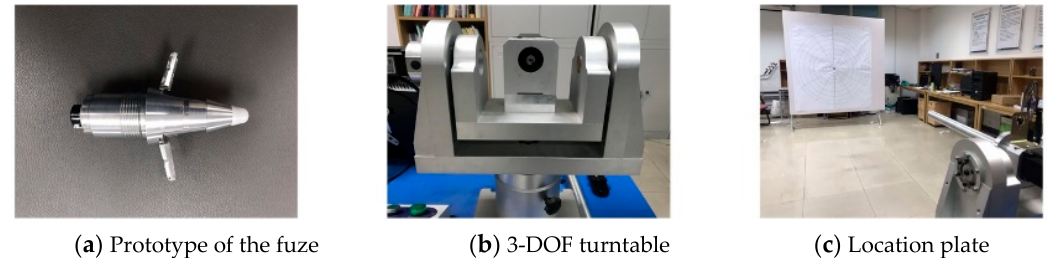
Figure 11. Experimental equipment and environment